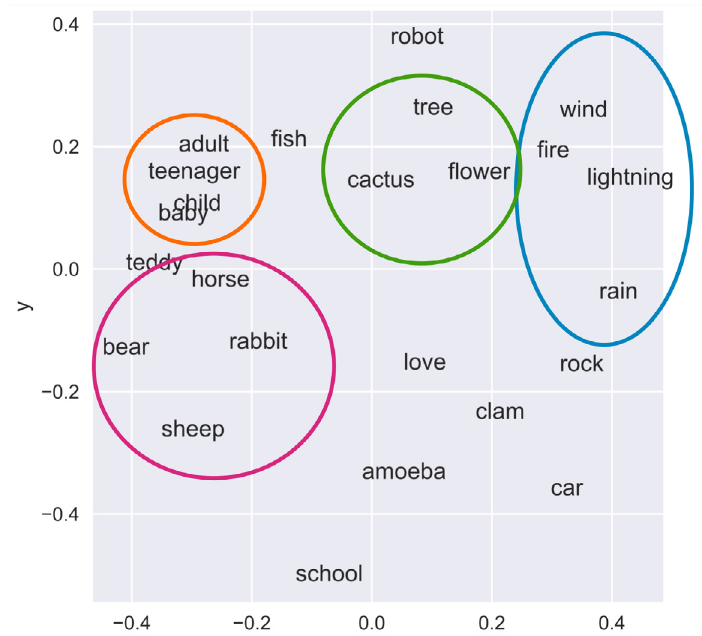
Figure 6 : A multidimensional scaling (MDS) plot showing the distances between the 24 nouns, averaged over the 100 langu- ages in the second half of the experiment. Two nouns are close in this plot if they tend to take the same noun-class marker within a language, and far apart if they tend to take different noun-class markers. Four animacy-related clusters (humans, plants, land animals, natural forces) have been circled for illustrative